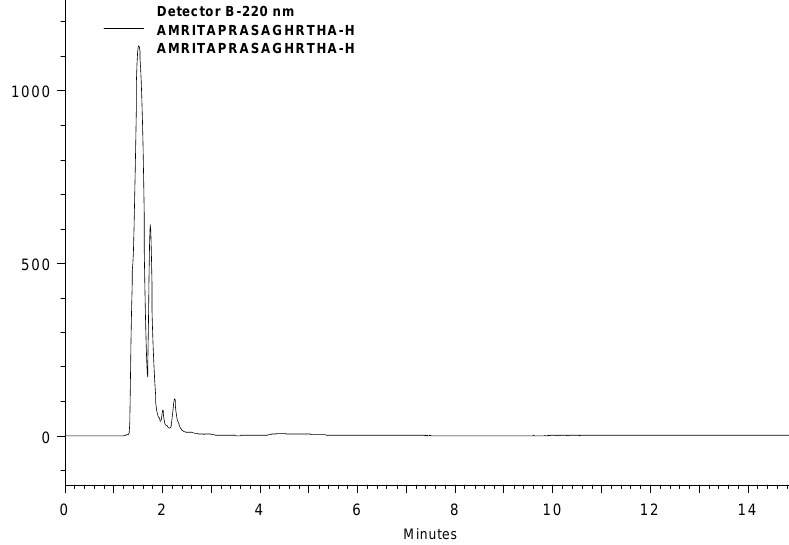
FIGURE 1FIGURE 1. HPLC CHROMATOGRAM OF AMRITAPRASA GHRITA